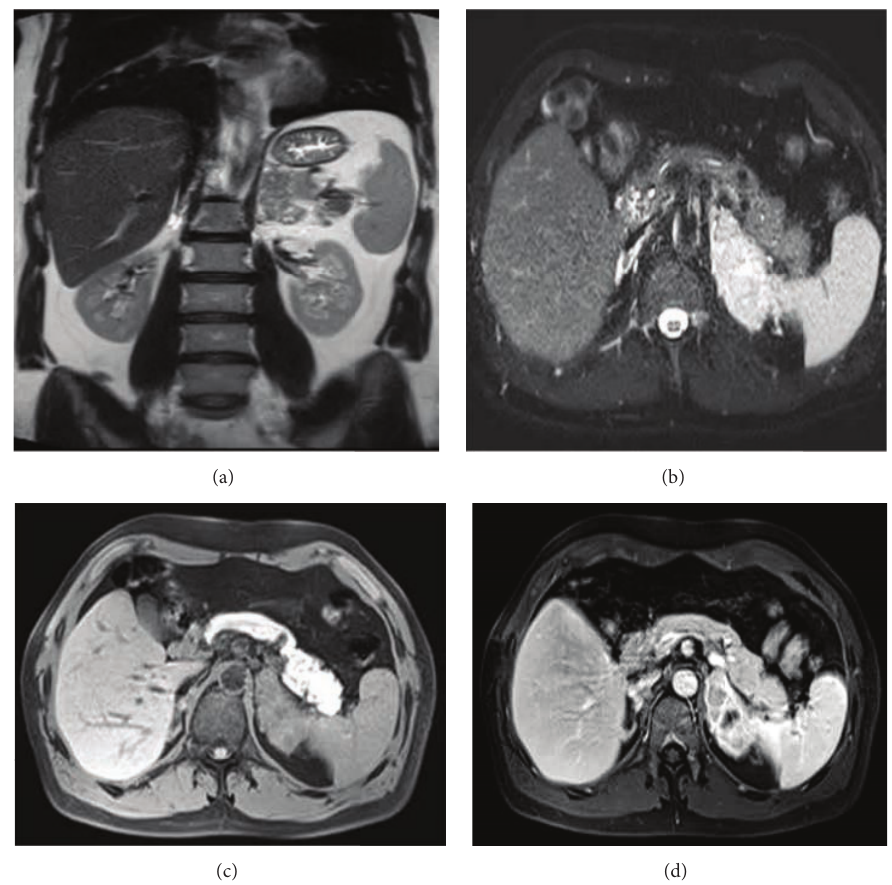
Figure 1: (a) Coronal T2-weighted and (b) axial fat saturated T2-weighted images show slightly hyperintense left adrenal gland lesion by comparison to spleen, with cystic degenerative components. (c) Axial fat saturated nonenhanced T1-weighted and (d) axial fat saturated enhanced T1-weighted enhanced images reveal diffuse and heterogeneous enhancement of